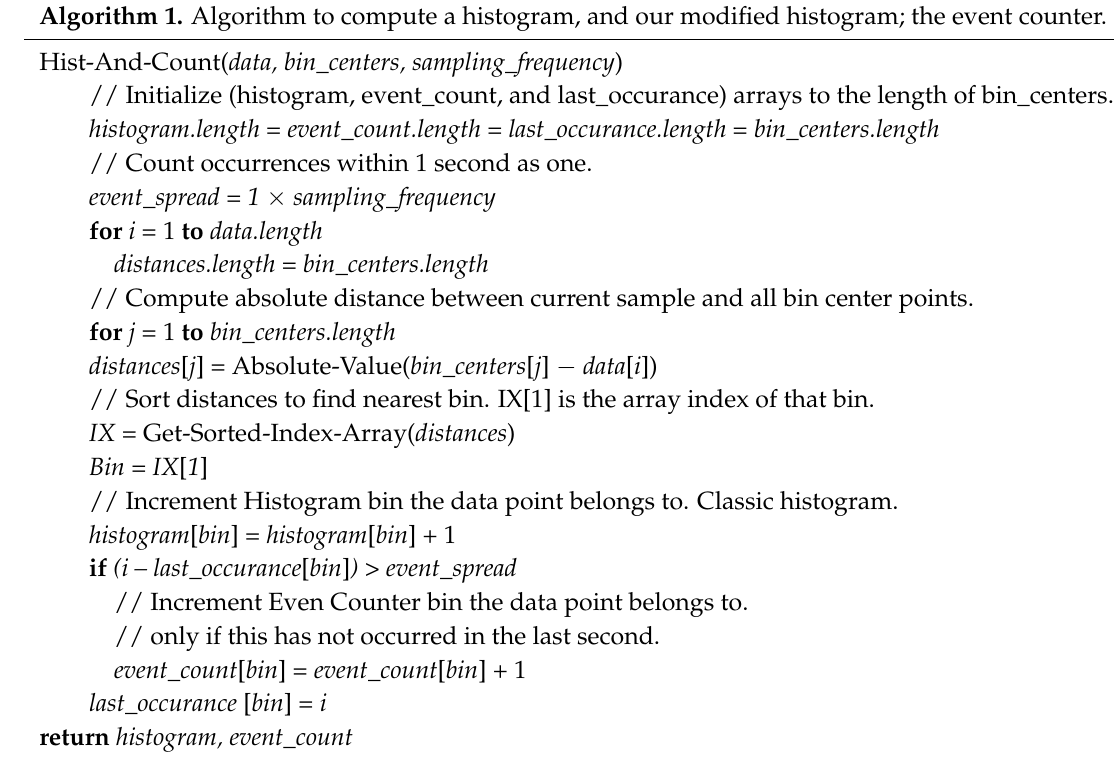
Algorithm 1. Algorithm to compute a histogram, and our modified histogram; the event counter. Hist-And-Count( data, bin_centers, sampling_frequency